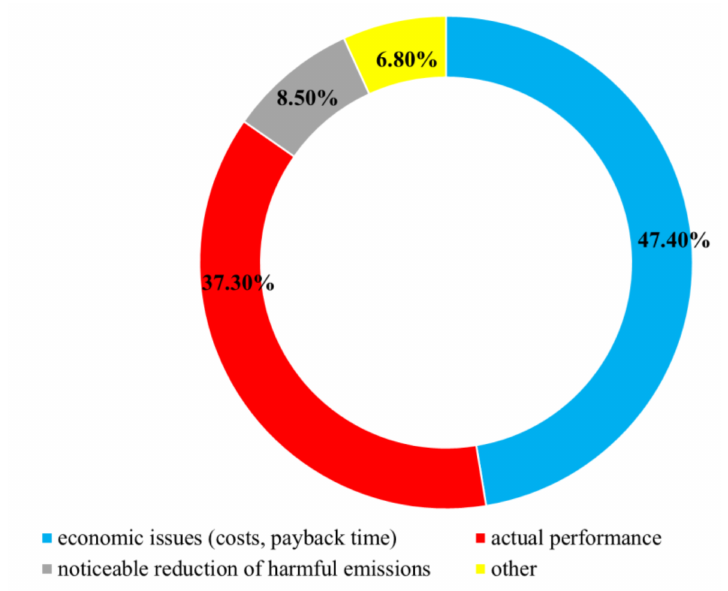
Figure 9. The factors affecting a decision concerning the system